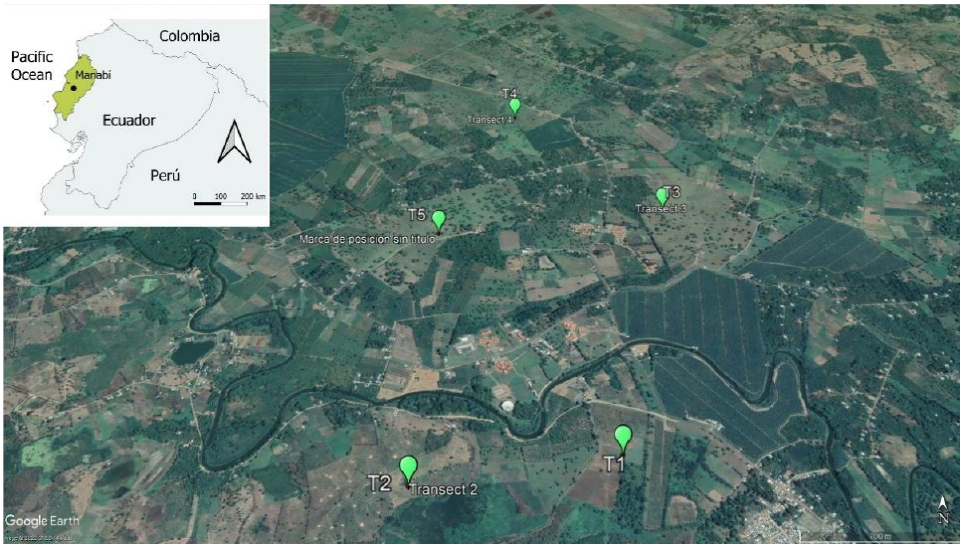
Figure 1. The location of the study area (black spot) in the province of Manabí (green area) in Ecuador. The location of the five transects are represented by the green spots. Map showing the location of Calceta (Ecuador). Google Earth, earth.google.com/web/ (20 March